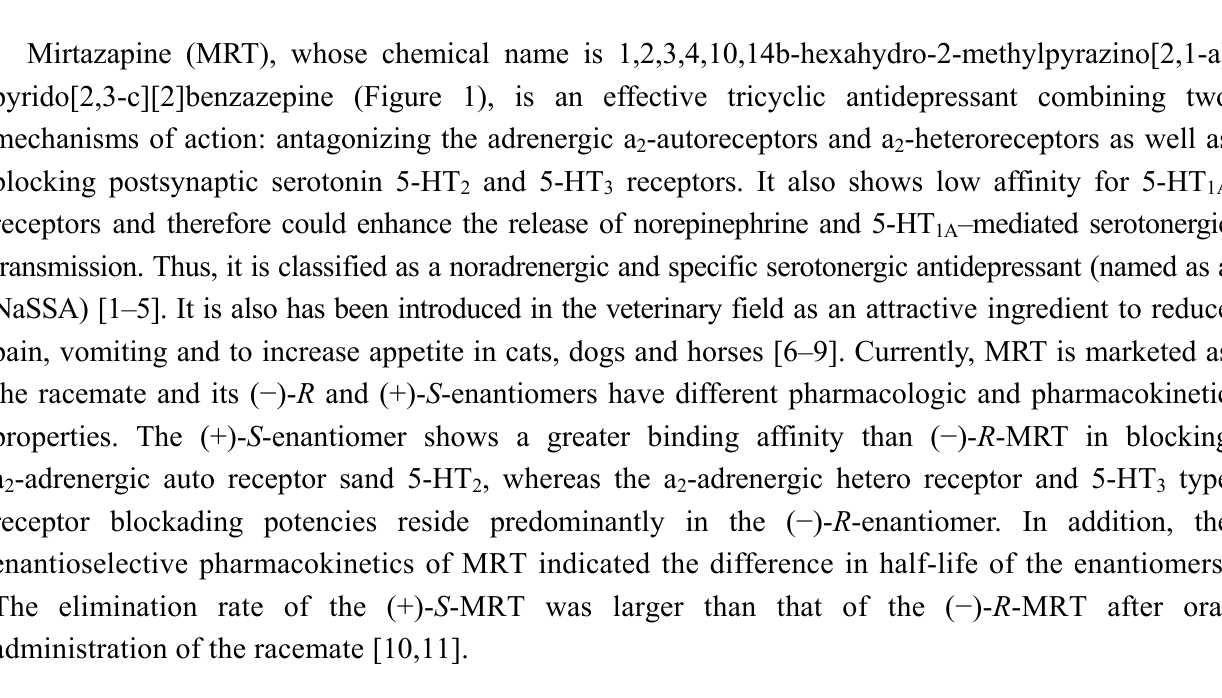
Figure 1. Chemical structures of ( a ) mirtazapine (MRT); ( b ) demethylmirtazapine